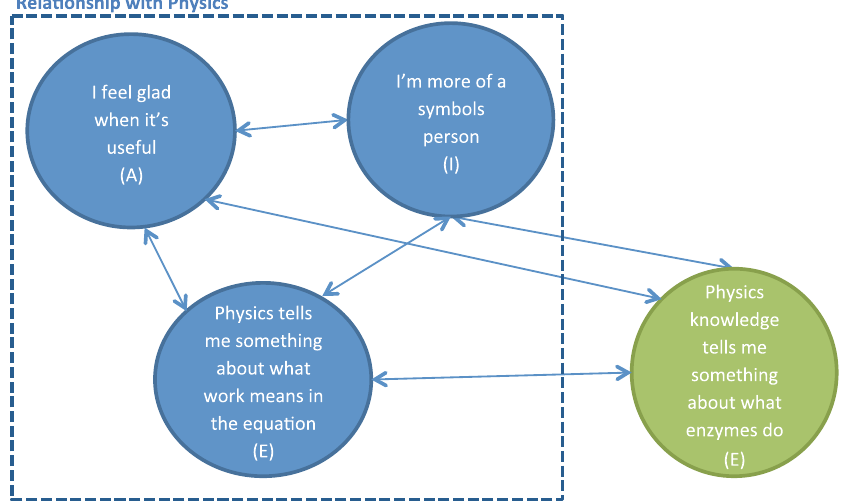
FIG. 6. A representation of the scientific reasoning moment Violet describes in Clip 7. The green circle outside of the relationship with physics indicates a developing epistemological stance that physics is relevant to biology